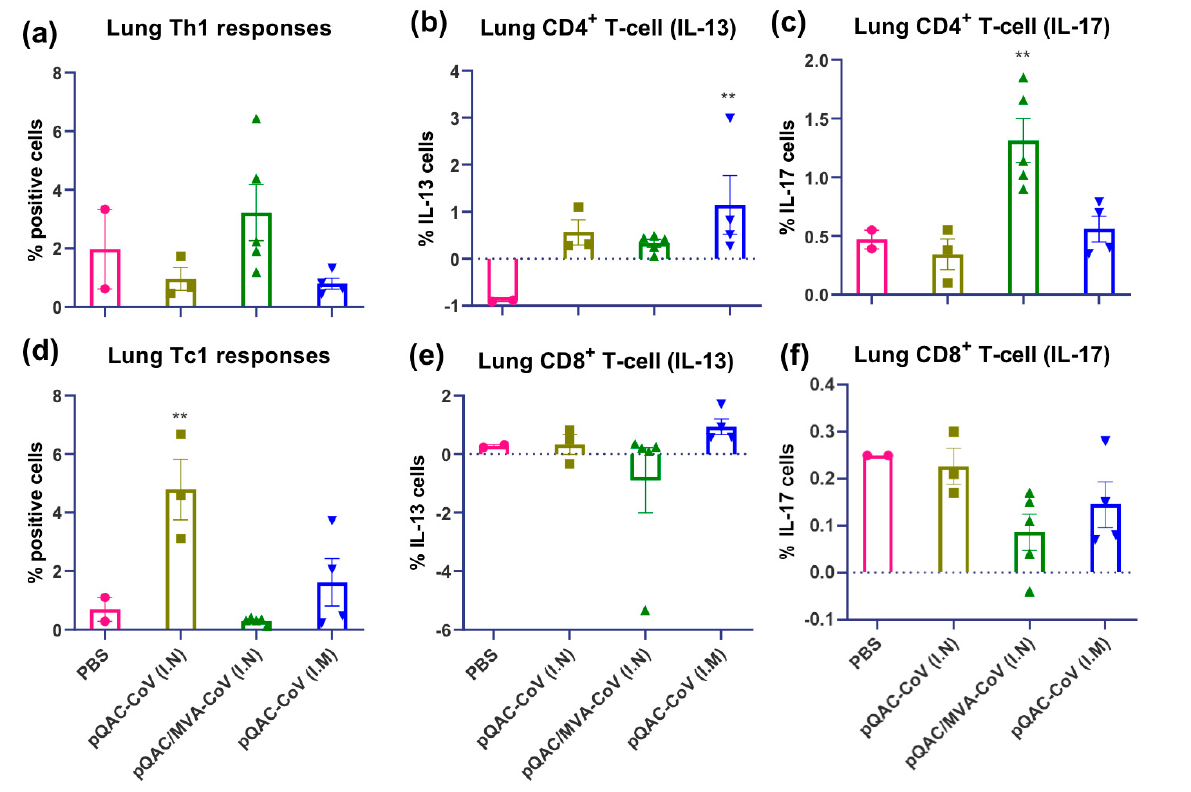
Figure 5. SARS-CoV-2 spike specific T cell responses in lungs of vaccinated C57BL/6 mice. Intracellular cytokine staining was performed on lungs harvested 3 weeks after final boost to assess T-cell responses. ( a ) Type 1 helper (Th1) responses (IFN- γ or TNF α or IL-2+), ( b ) type 2 helper (Th2) responses (IL-13+), ( c ) type 17 helper (Th17) responses (IL-17+), ( d ) type 1 cytotoxic (Tc1) responses (IFN- γ or TNF α or IL-2+), ( e ) type 2 cytotoxic (Tc2) responses (IL-13+), ( f ) type 17 cytotoxic (Tc17) responses (IL-17+) intracellular cytokine staining assays for lung T-cells in response to recombinant SARS-CoV-2 spike stimulation. Samples with lower live cells (<10,000) were excluded from analysis. Significance (*, p < 0.05; **, p < 0.01) was determined by ANOVA compared to PBS controls. Data show mean ± SEM.